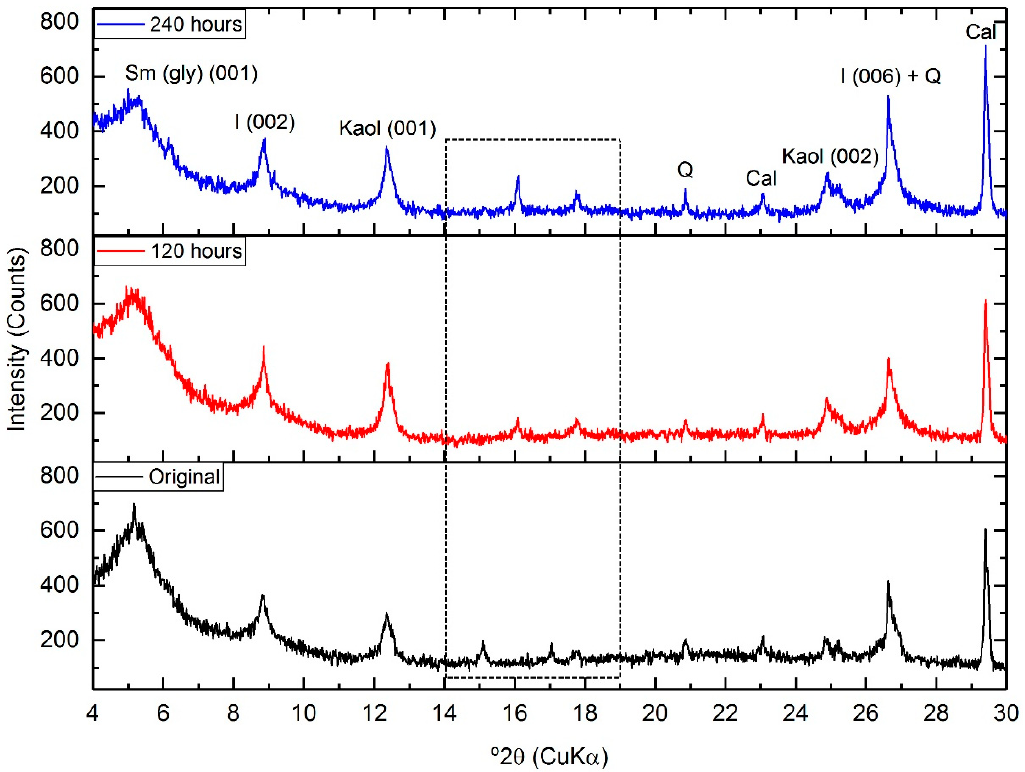
Figure 3. Comparison of XRD patterns of original blue marl oriented and original ethylene-glycol blue marl, after 120 and 240 h of interaction with sc-CO 2 (highlighted, see Figure 4).